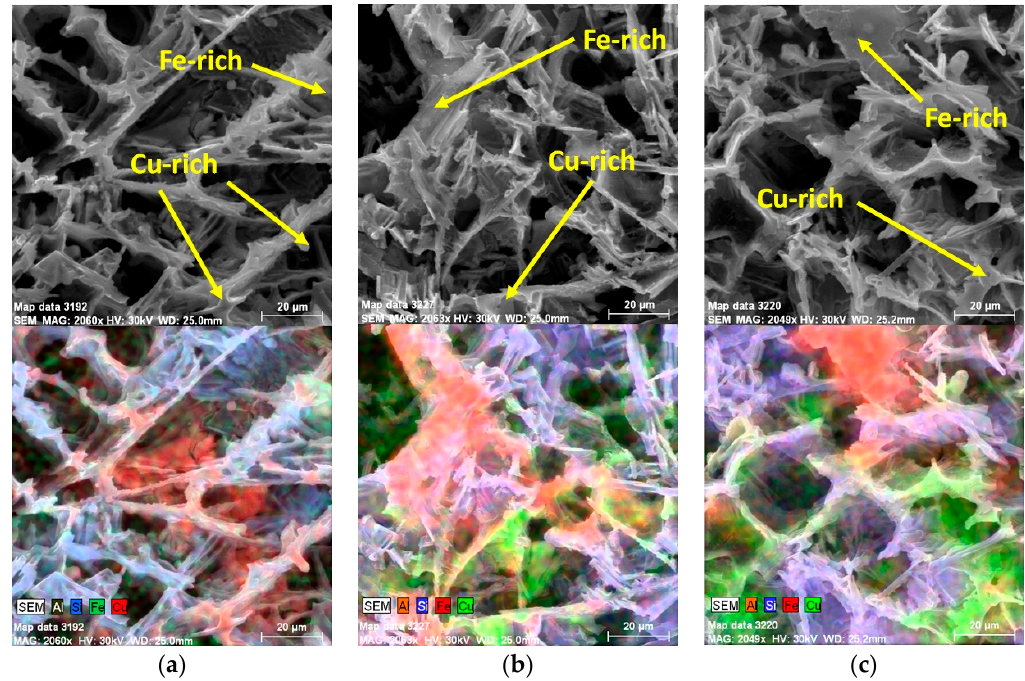
Figure 7. Changes of Cu-rich and Fe-rich phases of AlSi9Cu3 alloy depend on the ratio of returnable